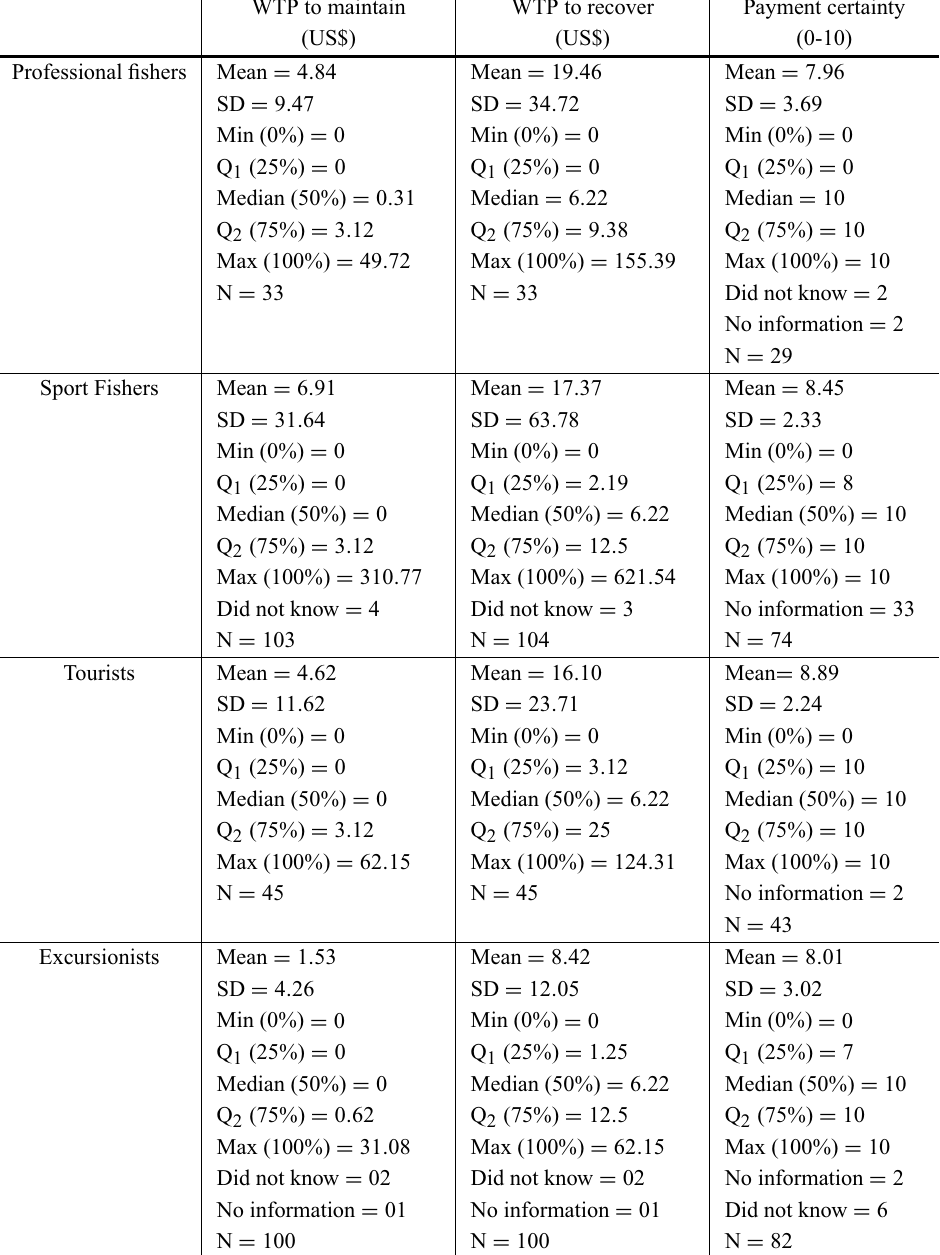
Monthly mean, standard deviation (SD), minimum, maximum, median, 25% and 75% quartiles (Q 1 and Q 2 ), number of interviews (N) of WTP to maintain and to recover the environment, and the payment certainty of the four user categories (R$ 1.60 = US$ 1.00